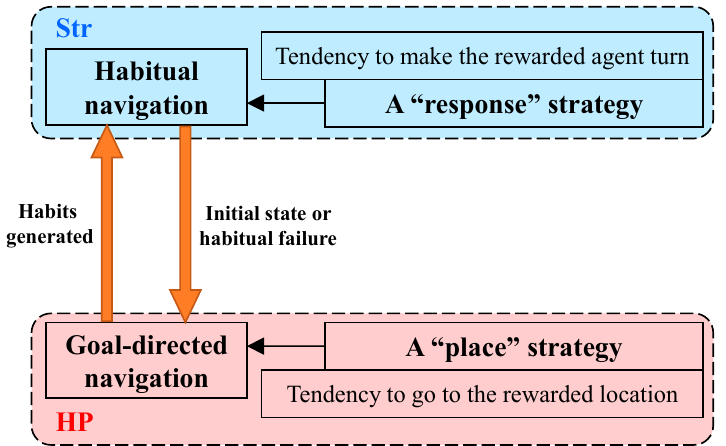
Figure 4. Relationship between habitual and goal-directed navigation. The agent chooses a path according to the goal-directed mechanism until it has acquired enough experience and formed habits and then navigates according to habits, which is consistent with animal navigation behavior.